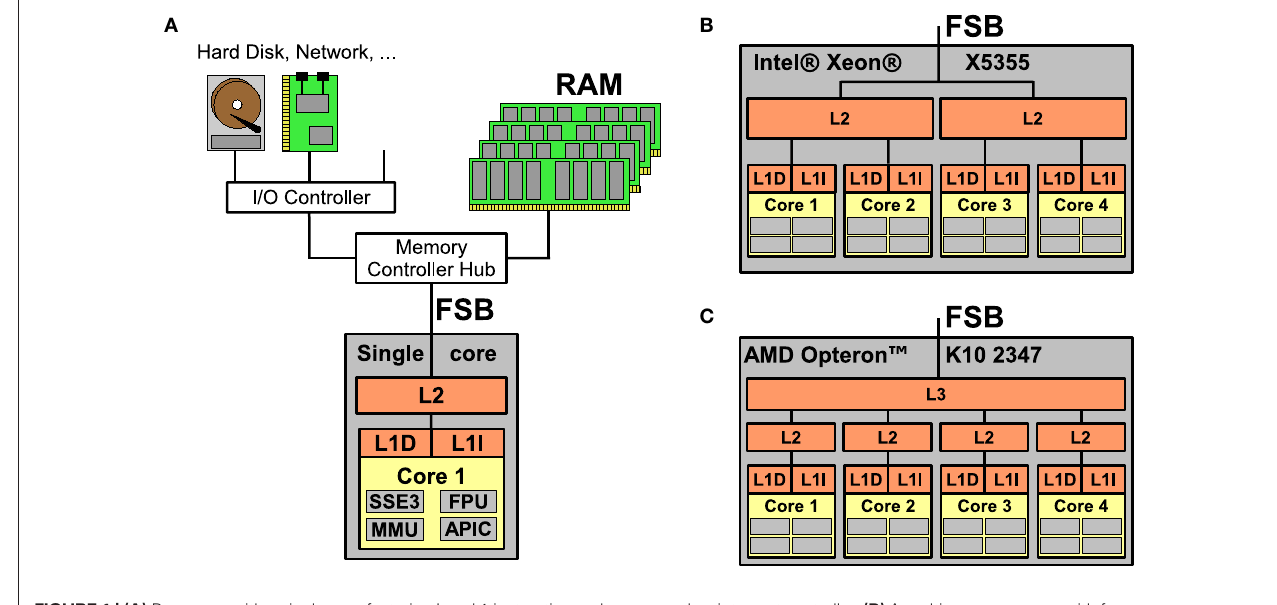
FIGURE 1 | (A) Processor with a single core featuring Level 1 instruction and data caches (L1I and L1D), Level 2 cache (L2), and main memory (RAM) accessed via the Front Side Bus (FSB); the core is equipped with subunits for e.g. vector arithmetics, fl oating point processing, memory management